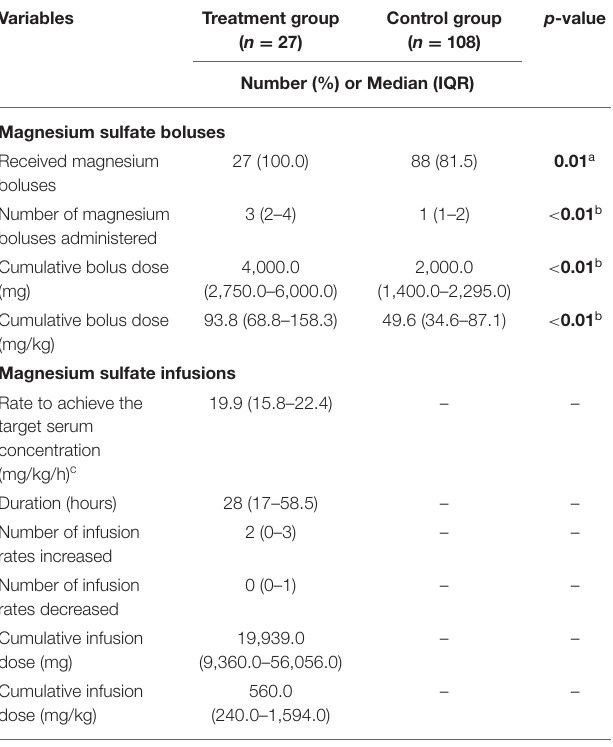
TABLE 2 | Characteristics of magnesium sulfate boluses and infusion in treatment and control groups ( n = 135).